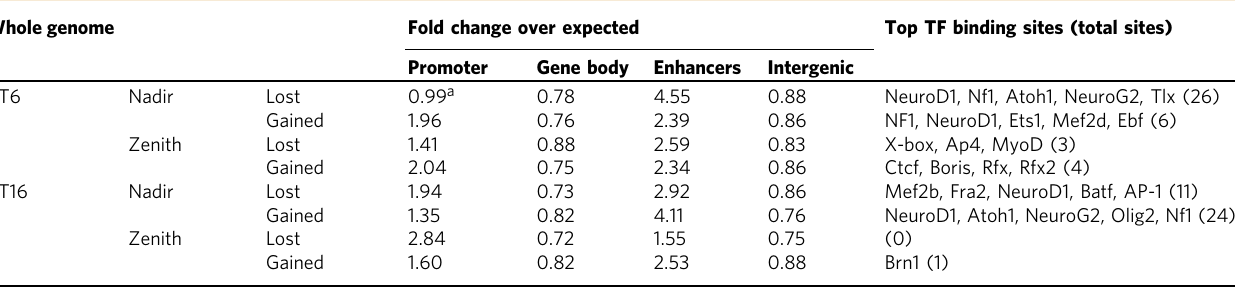
Table 1 Genomic region enrichment analysis of directional diurnal CpGs Whole